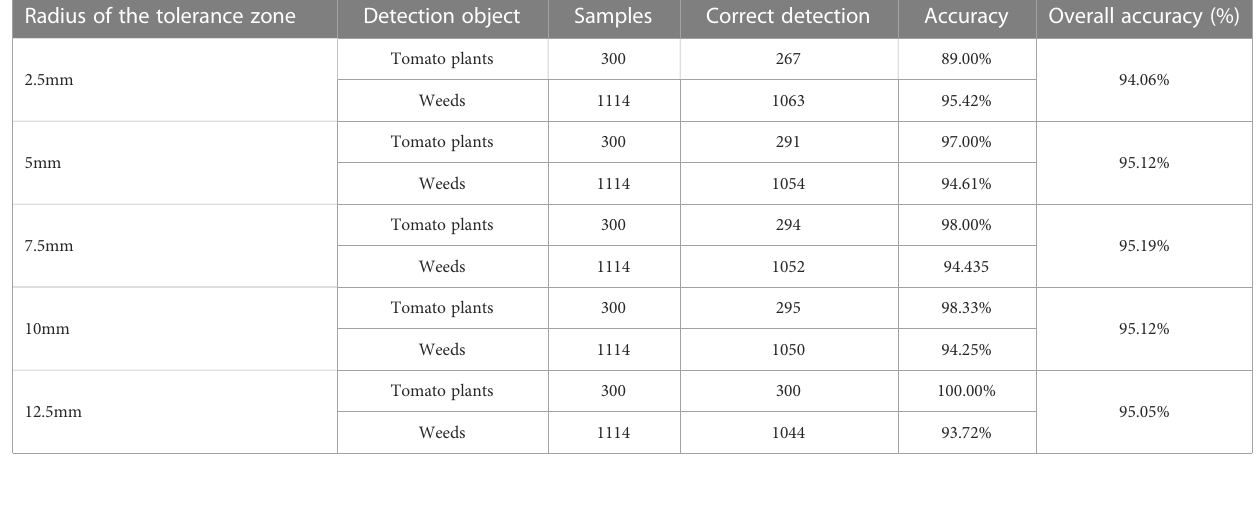
TABLE 2 The results of detecting tomato plants based on different radius of the tolerance zone.